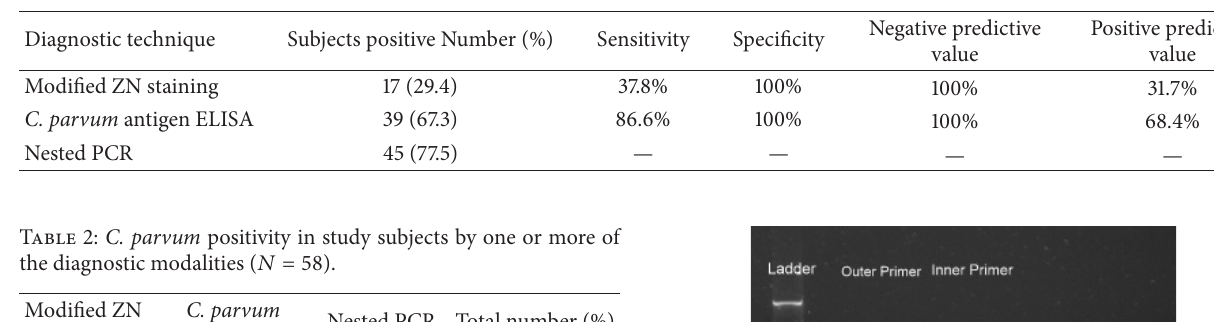
Table 1: C. parvum detected in study subjects by the various methods and the sensitivity, specificity, and predictive values of the modified ZN staining and antigen ELISA ( 𝑁 = 58 ).